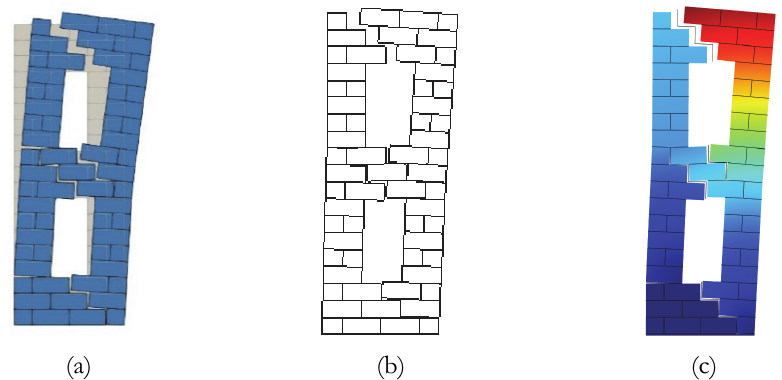
Figure 8: Collapse mechanism for Example 5, horizontal live load: ( a ) ALMA 2.0, ( 𝑏 ) FEM/DEM, ( 𝑐 ) FEM